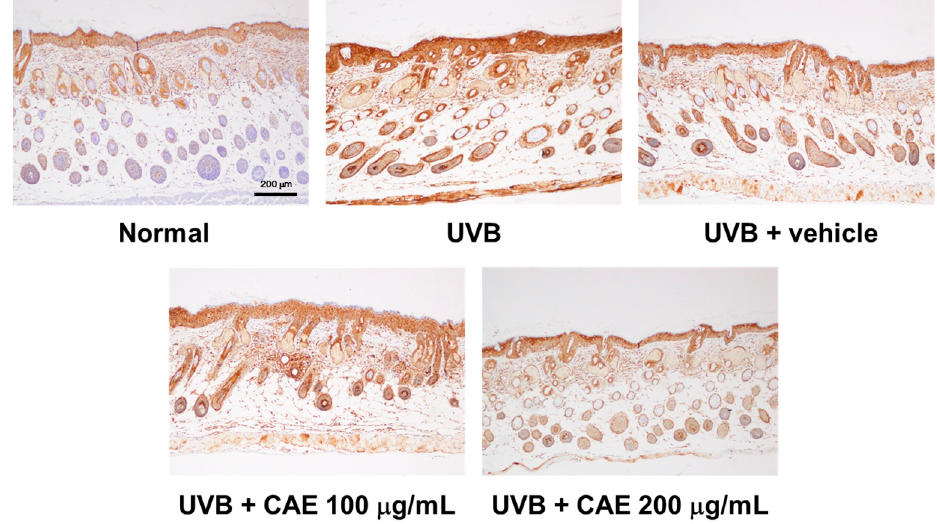
Figure 17. Immunohistological staining for MMP-1 in the hairless mouse skin after UVB exposure and CAE treatment. MMP-1 expression increased after UVB irradiation in the mouse skin, whereas CAE treatment inhibited the effect.